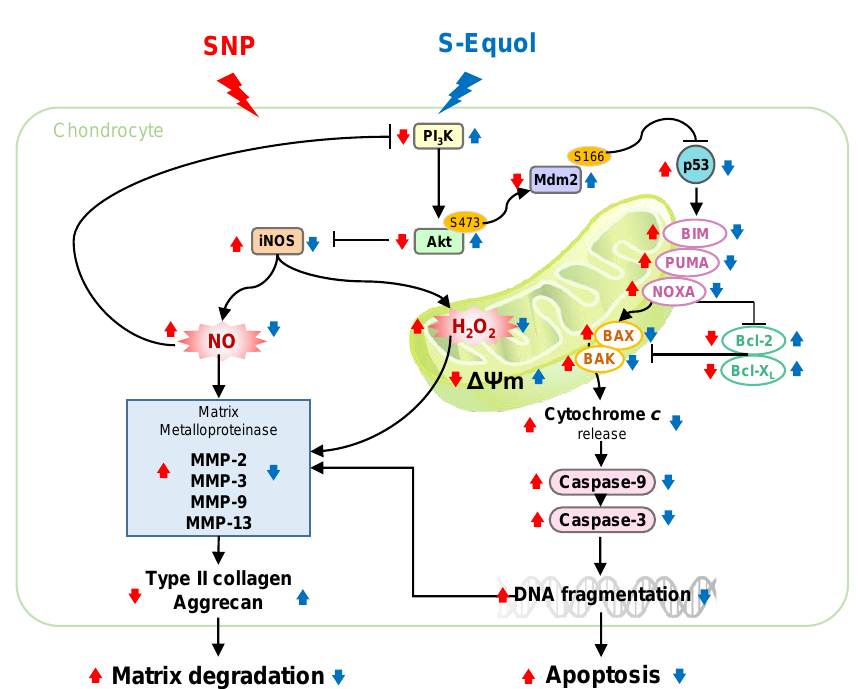
Figure 8. Schematic of S-Equol protects chondrocyte against SNP’s damage. Treatment of chondrocyte with SNP could increase p53, intracellular NO and H 2 O 2 levels and decrease mitochondrial membrane potential (ΔΨM). Furthermore, the NO could activate MMPs, resulting in type II collagen and aggrecan degradation. Simultaneously, p53 could increase expressions of pro-apopototic proteins including BIM, PUMA, NOXA, BAX, and BAK, and cause a decrease in anti-apoptotic proteins including Bcl-X L and Bcl-2 expression, resulting in the release of cytochrome c , activation of caspase-9 and caspase-3, and finally the induction of apoptosis. The addition of S-Equol could lessen those effects caused by SNP. Moreover, S-Equol could active the PI 3 K/Akt pathway, an upstream of apoptosis and NO production, including an increase in phosphorylation of Akt and Mdm2 to inhibit p53 and NO production, by which the apoptosis and matrix degradation caused by SNP are decreased. Red : enhanced by SNP; Red : decreased by SNP; Blue : enhanced by S-Equol; Blue : decreased by S-Equol.